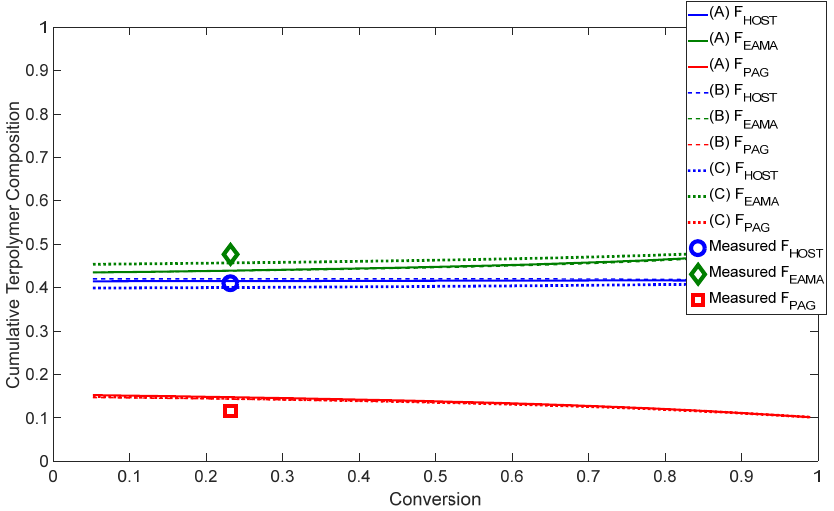
Figure 2. HOST / EAMA / PAG terpolymer composition prediction for f 1,0 / f 2,0 / f 3,0 = 0.4 / 0.5 / 0.1 Figure 2. HOST/EAMA/PAG terpolymer composition prediction for f 1,0 /f 2,0 /f 3,0 = 0.4/0.5/0.1 (experimentally measured composition for TPF10 from Pujari et al. (experimentally measured composition for TPF10 from Pujari et al. [5]).